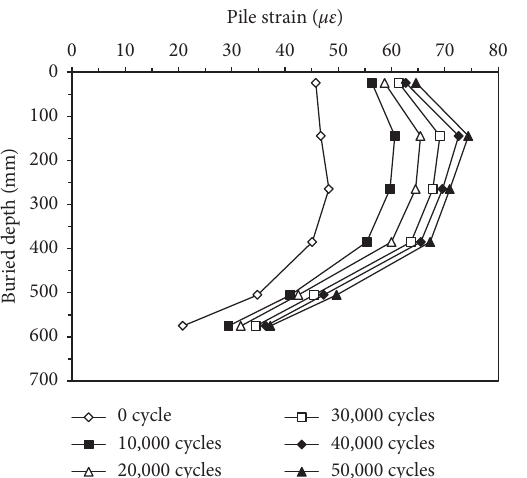
Figure 8: Pile strain-buried depth curves of side piles with different numbers of load cycles under cyclic